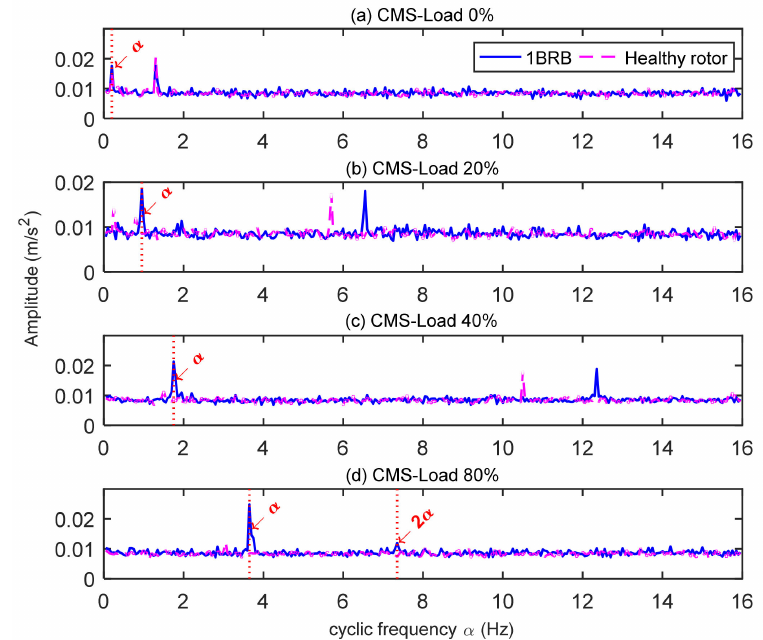
Figure 11. Vibration spectrum of the healthy induction motor and faulty motor with one broken rotor